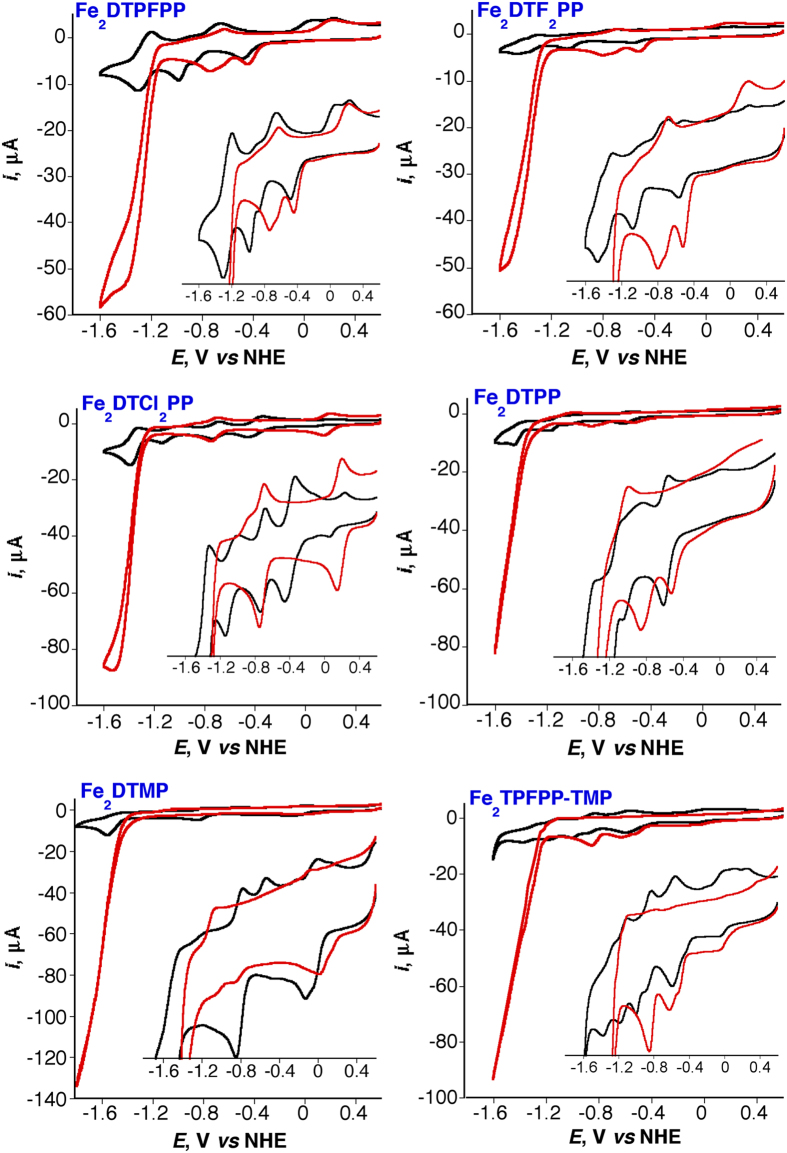
Cyclic voltammograms of the six Fe-porphyrin dimers (0.5 mM) in DMF/10% H2O at 50 mV/s scan rate under Ar (black lines) and CO2 (red lines).Insets: magnified traces of CVs.